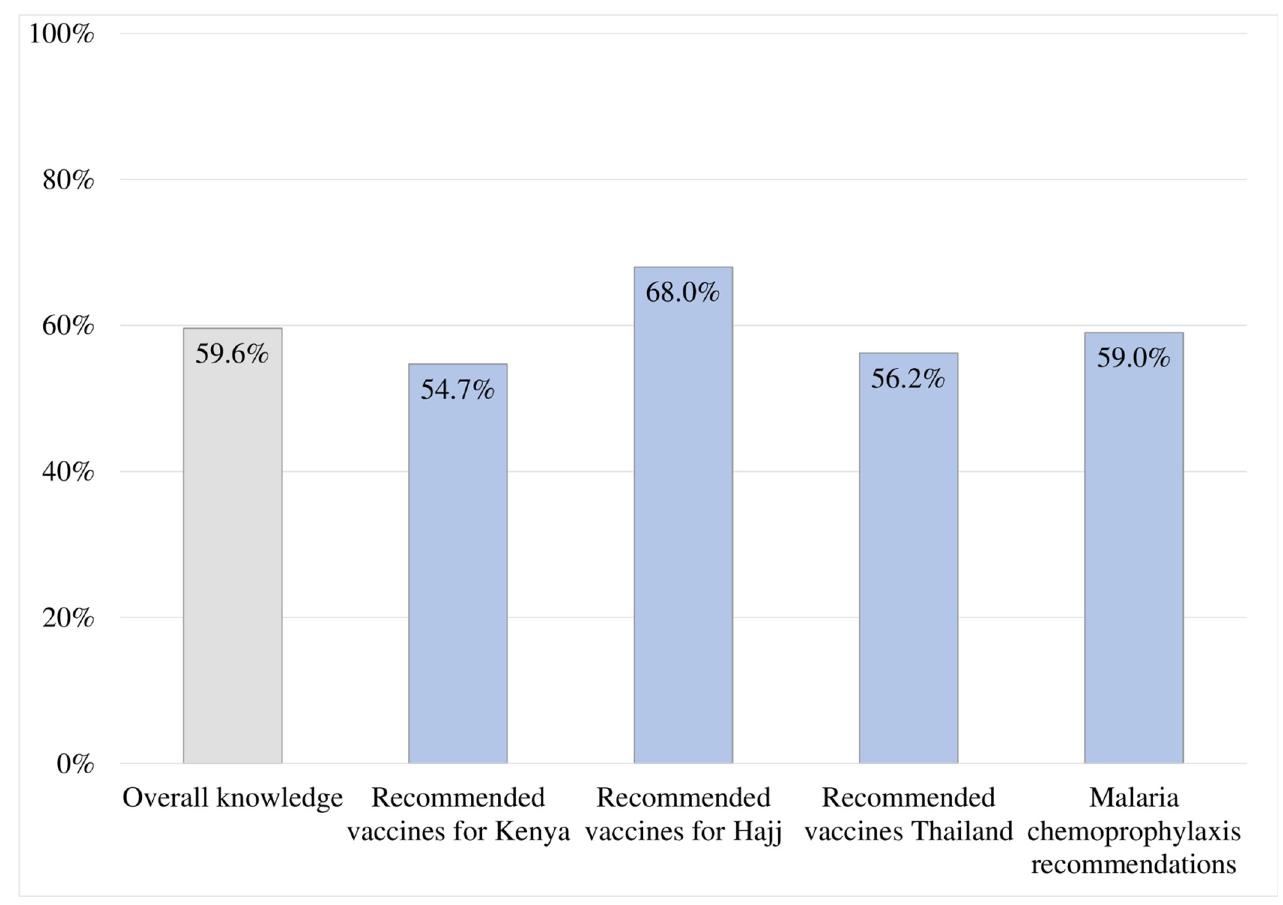
Fig 2. Primary care physicians’ mean percentage knowledge scores (N =